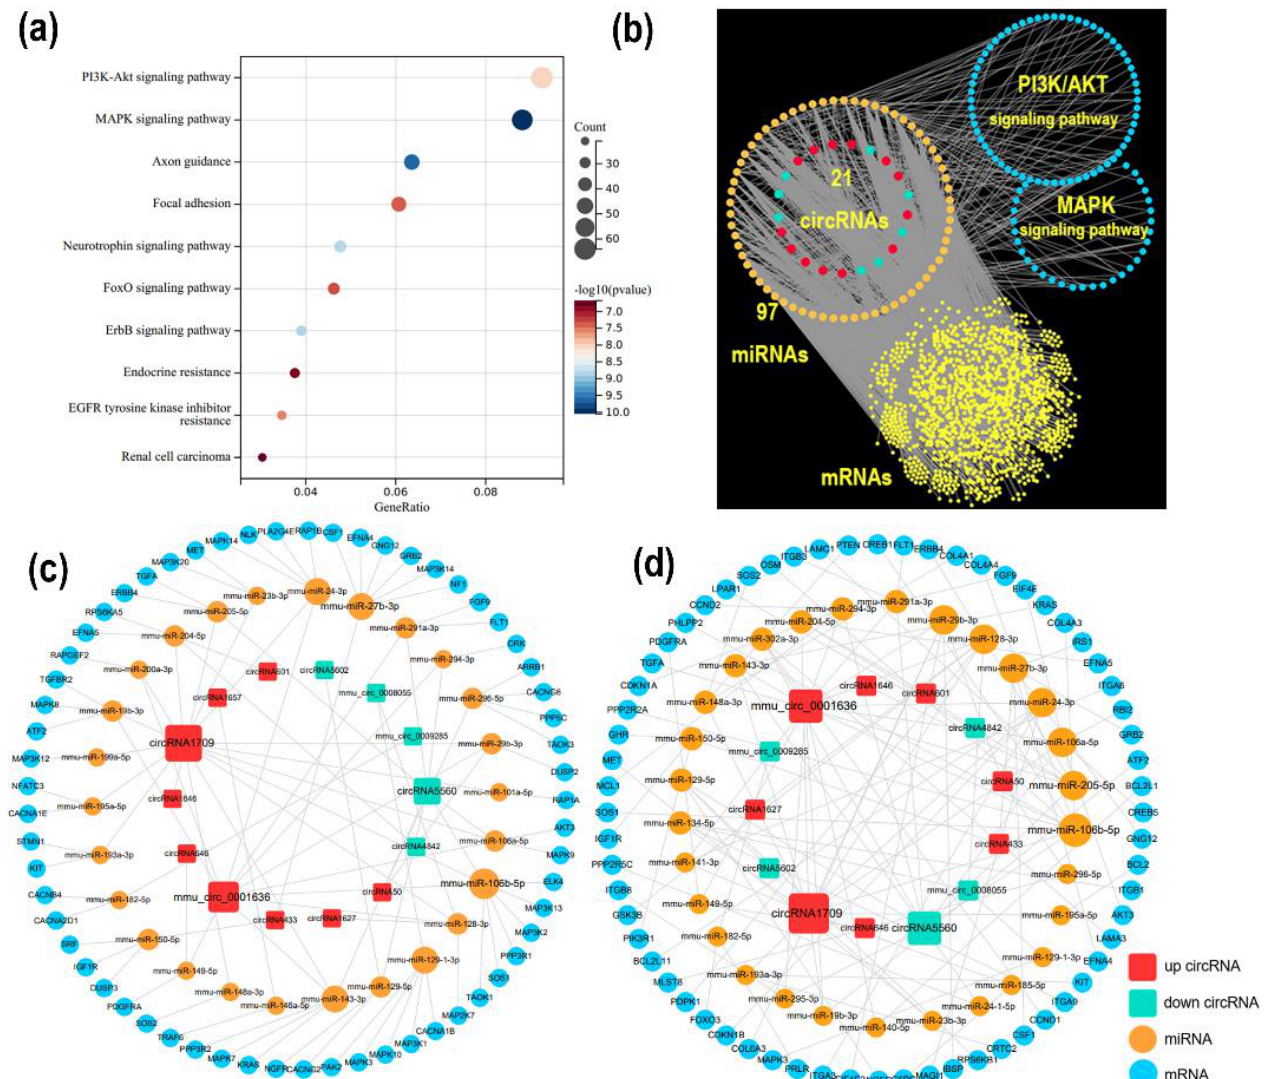
Figure 4. Construction of ceRNA network. ( a ) Top five enriched GO terms and KEGG pathways of target mRNA with Sangerbox; ( b ) ceRNA network with 21 DE circRNAs (red represents upregulated circRNAs, cyan represents downregulated circRNAs), 97 miRNAs (orange represents miRNAs), and 1420 mRNAs (blue represents mRNAs involved in MAPK and PI3K/AKT signaling pathway, and yellow represents the remaining mRNAs). Among the 1420 mRNAs, 61 were involved in the MAPK signaling pathway and 64 were involved in the PI3K/AKT signaling pathway; ( c ) CeRNA network of MAPK signaling pathway; ( d ) CeRNA network of PI3K/AKT signaling pathway.